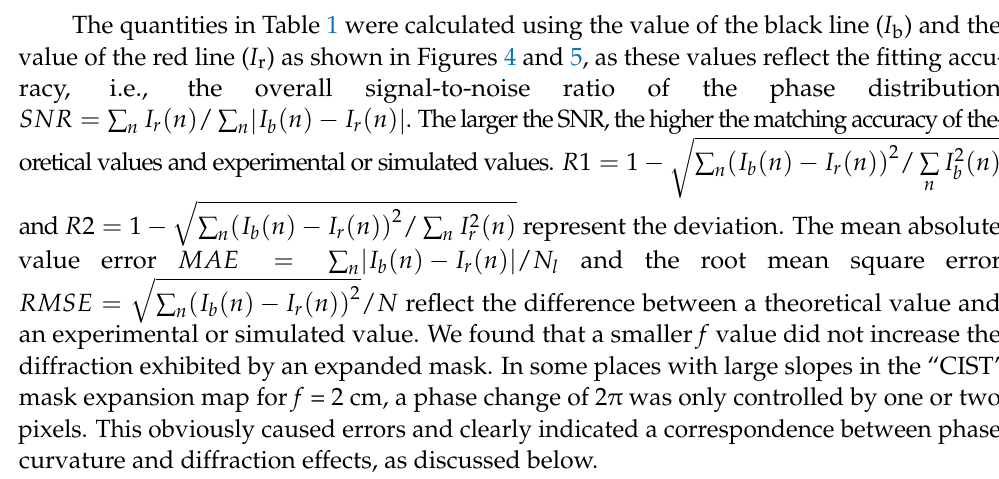
Figure 5. Comparison of the simulated (black line) and target irradiance (red line) of the diffraction intensity distribution of the “CIST” expansion mask (line 450th in the horizontal direction of diffraction pattern) with different f value, where ( a ) f = 2 cm and ( b ) f = 5 cm.